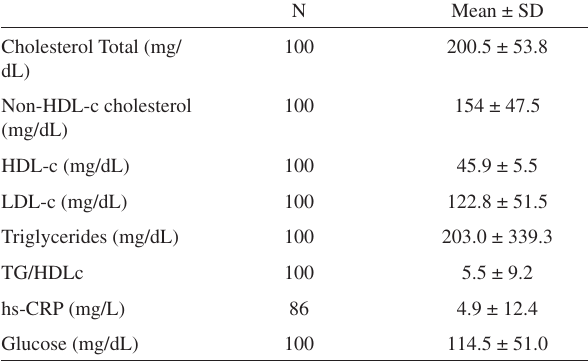
Table 2- Laboratory test scores